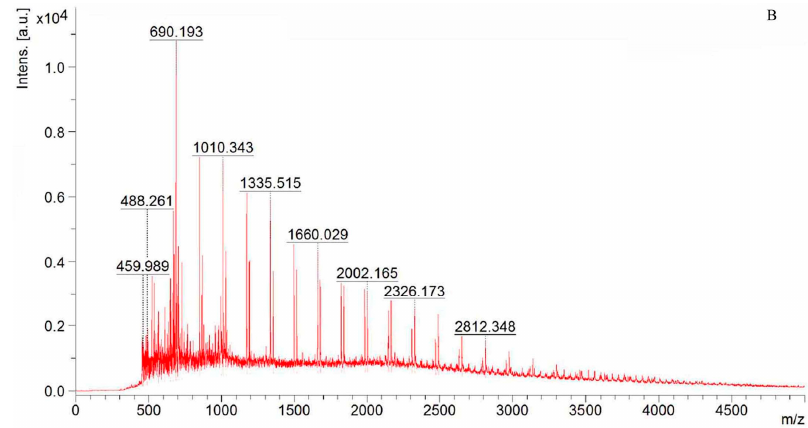
Figure 1. HPGPC curve ( A ) and MALDI-TOF mass spectrum ( B ) of CP-A. Figure 1 . HPGPC curve ( A ) and MALDI-TOF mass spectrum ( B ) of CP-A. Figure 1 . HPGPC curve ( A ) and MALDI-TOF mass spectrum ( B ) of CP-A.